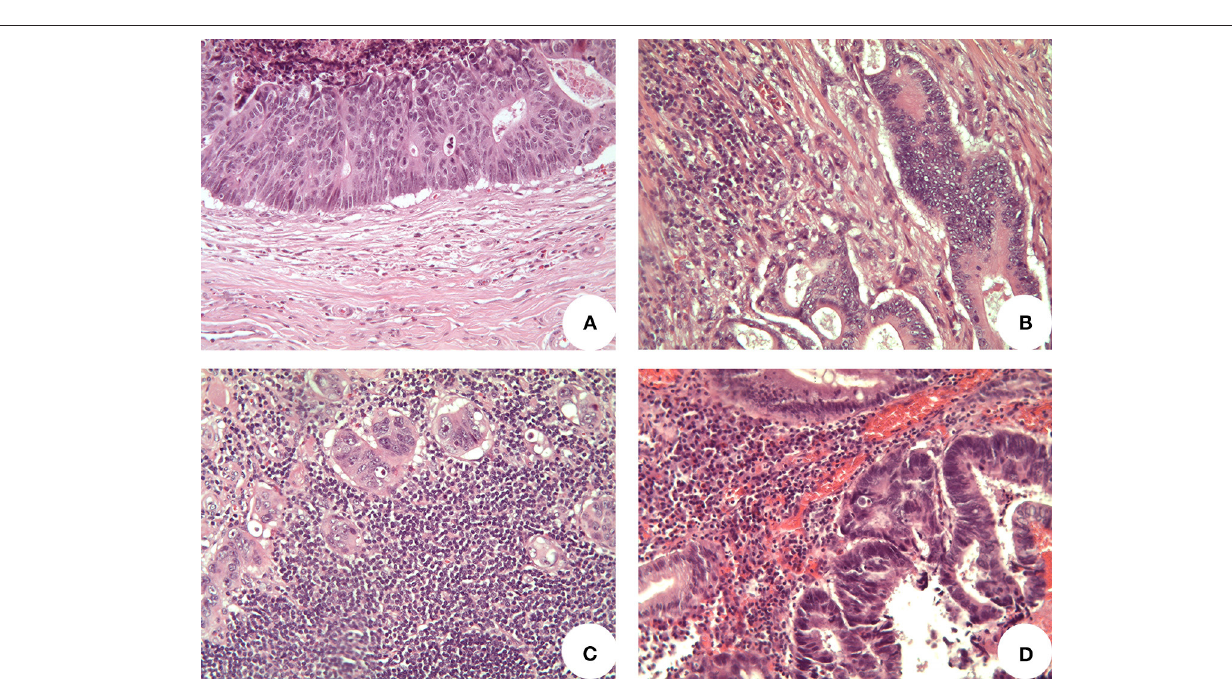
FIGURE 2 | Representative images of tumor infiltrating lymphocytes (TILs) (original magnification 200x). (A) “Absent TILs” cases presented no lymphocytes at the invasive front of tumor; (B) “mild TILs” cases showed scattering lymphocytes partially surrounding tumor cells; (C) “high TILs” cases presented several lymphocytes continuously outlining tumor cells at the invasive tumor front and extending in the surrounding stroma; (D) lymphocytes located in superficial tumor layers were not considered, as well as lymphocytes within the tumor bulk. cases; 83.6%). TILs were mild in most cases (165 cases; 79.7%), cases presented an infiltrative growth pattern (134 cases; 64.7%) while high-grade tumor budding and lymphovascular invasion and were graded as moderately differentiated (G2) (169 cases; were observed in a minority (8.7 and 3.9%, respectively) of 81.6%), while mucinous features were frequently absent (173